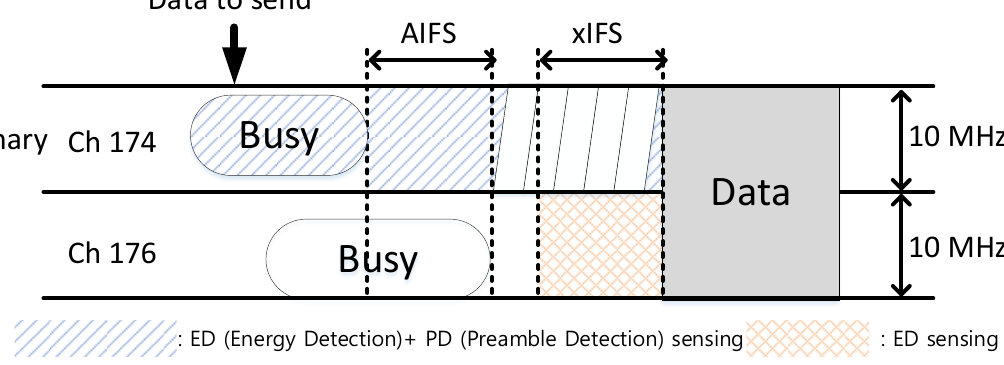
Figure 3. Application of conventional channel-extension scheme to 20-MHz channel access.